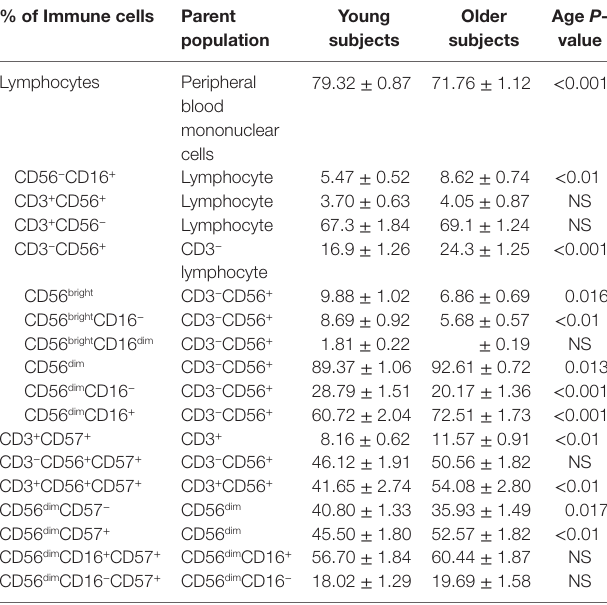
Data are mean ± SEM for n = 51 young subjects and n = 52 older subjects. Differences between the two cohorts were analyzed by independent samples t-tests (2-tailed).